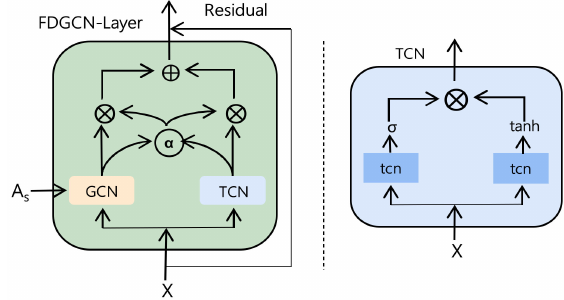
Figure 5. Adaptive gated spatio-temporal fusion